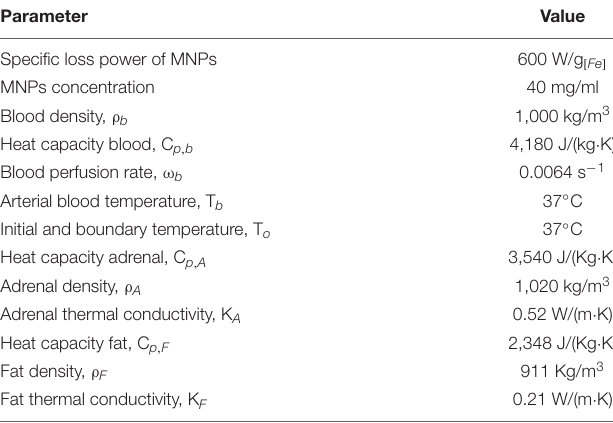
TABLE 1 | Parameters for finite element modeling